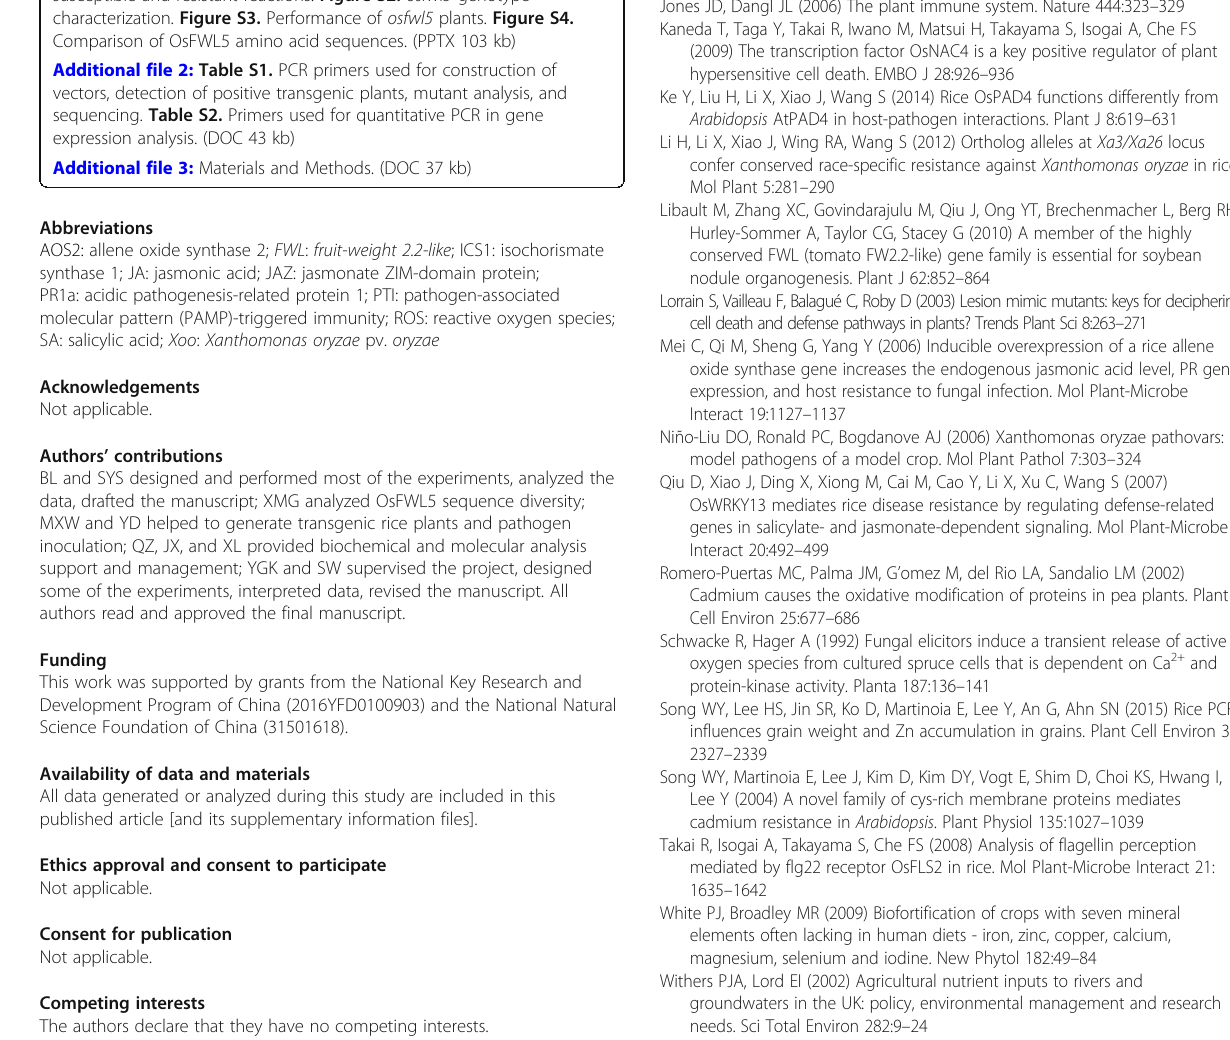
Additional file 1: Figure S1 . Expression patterns of OsFWL5 in rice susceptible and resistant reactions. Figure S2. osfwl5 genotype characterization. Figure S3. Performance of osfwl5 plants. Figure S4. Comparison of OsFWL5 amino acid sequences. (PPTX 103 kb) Additional file 2: Table S1. PCR primers used for construction of vectors, detection of positive transgenic plants, mutant analysis, and sequencing. Table S2. Primers used for quantitative PCR in gene expression analysis. (DOC 43